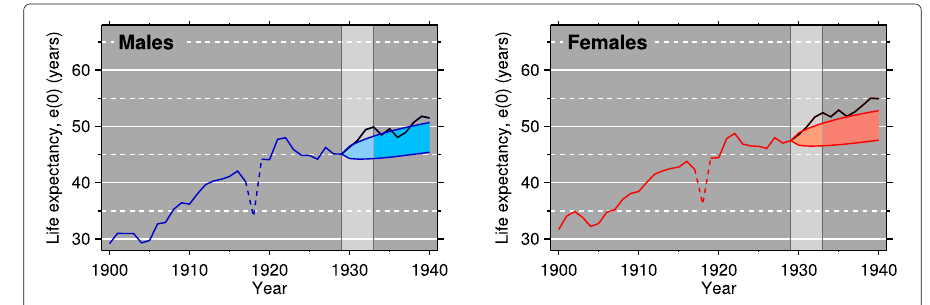
Fig. 4 Same as Fig. 2, but for nonwhites